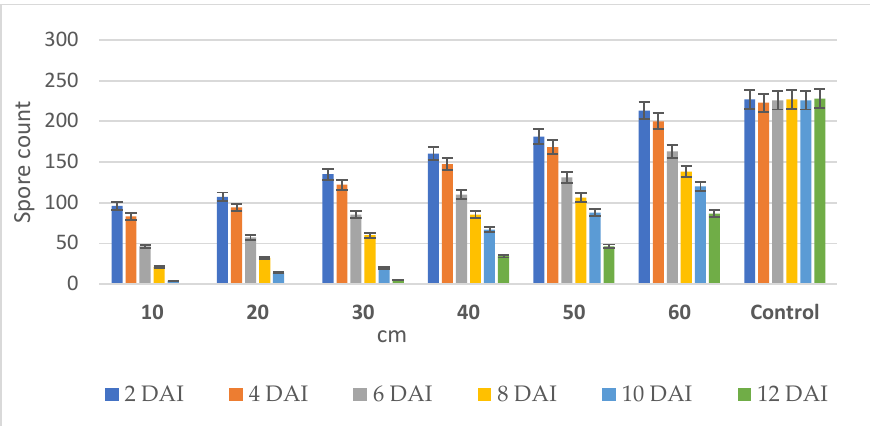
Figure 6. Performance of M. spicata volatilomes diffusion from the vermiculite ball over a distance against F. oxysporum f. sp. lycopersici .